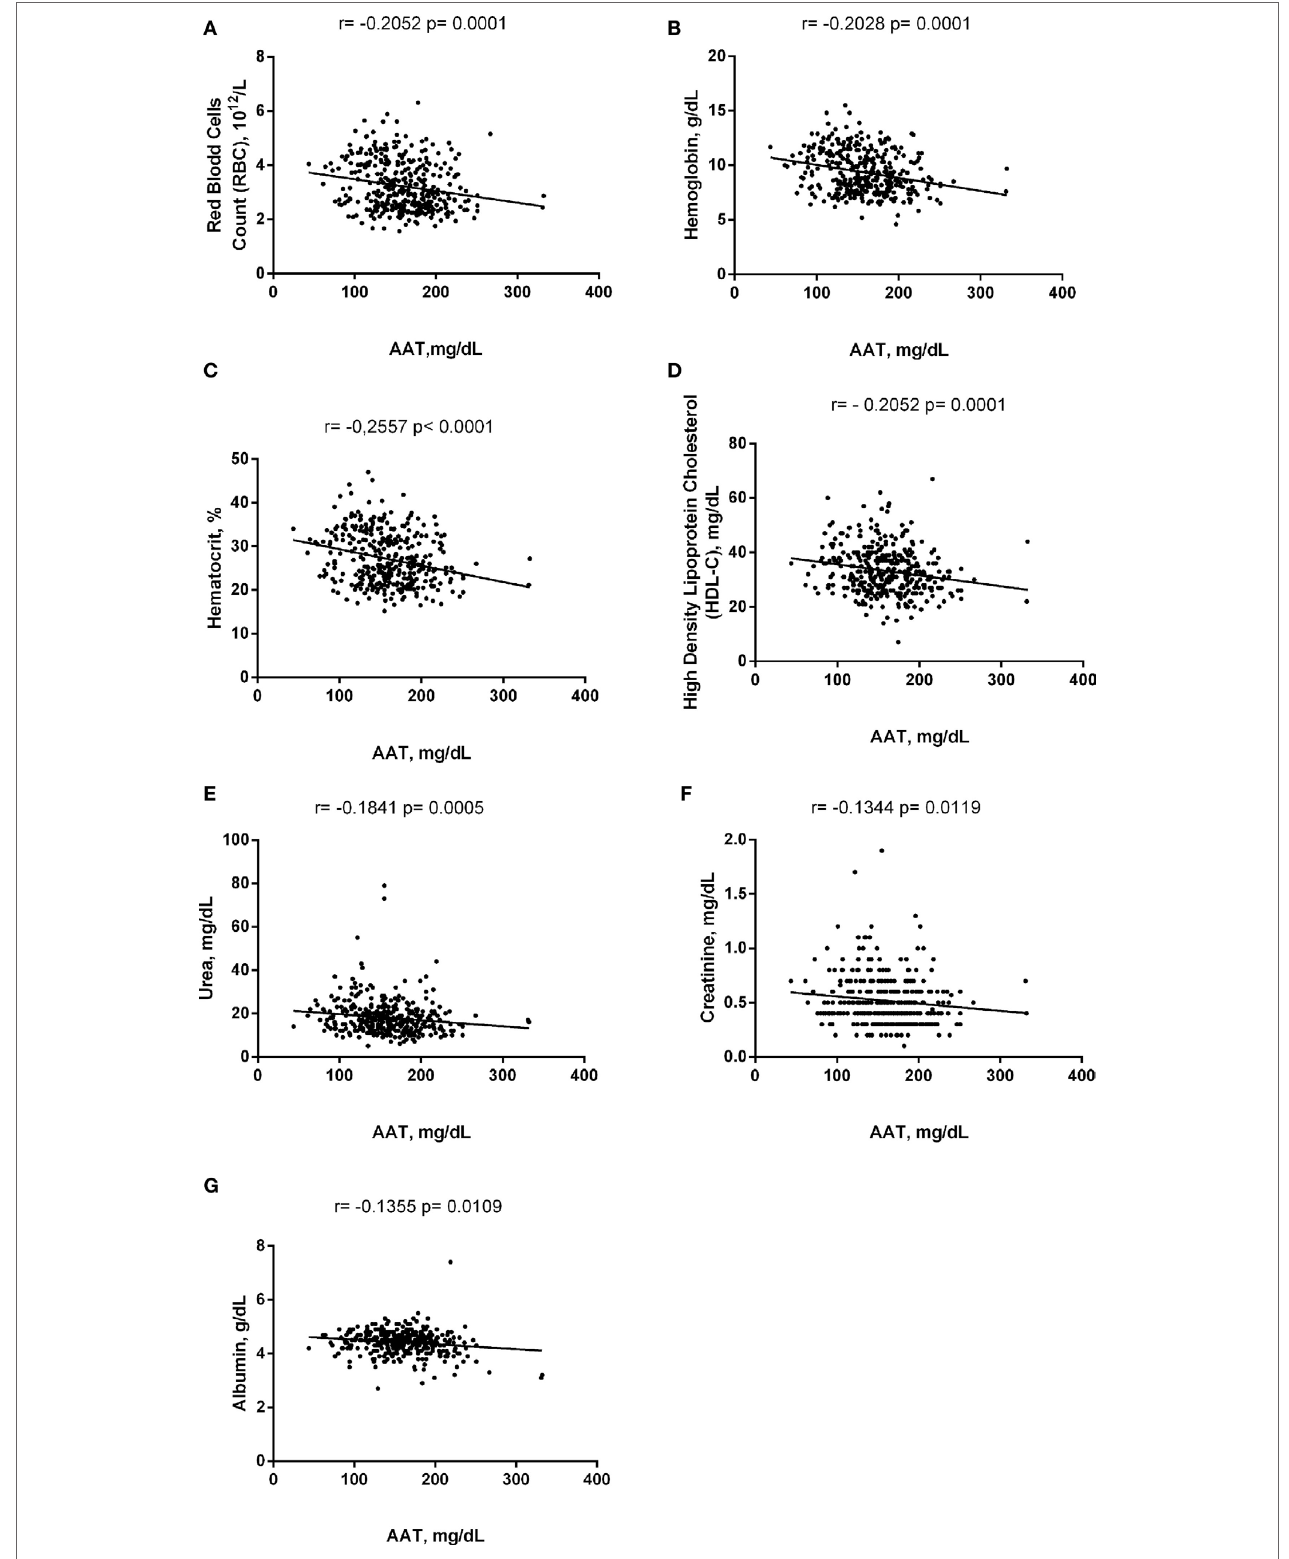
FigUre 2 | Negative correlations of alpha-1 antitrypsin (AAT) with laboratory parameters in steady-state sickle cell disease patients. (a) Red blood cells (RBCs); (b) hemoglobin; (c) hematocrit; (D) high-density lipoprotein of cholesterol (HDL-C); (e) urea; (F) creatinine; (g)